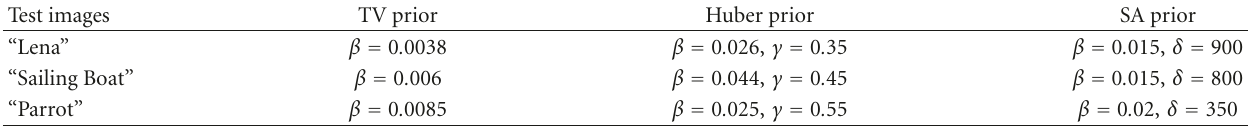
Table 2: Optimal parameter settings.